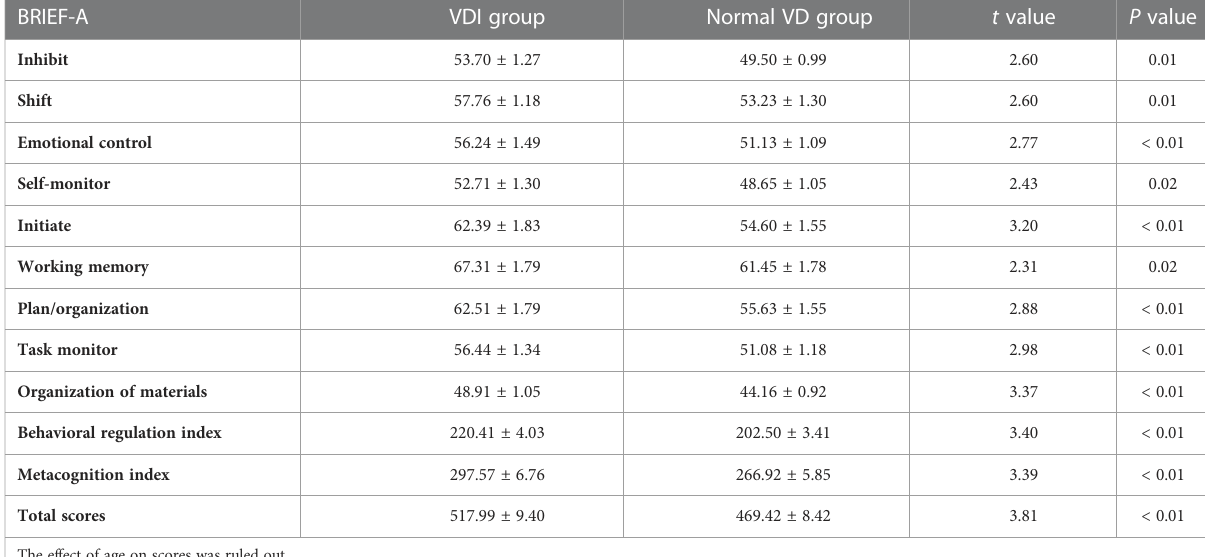
TABLE 3 Differences of BRIEF-A scores in T2DM patients with different 25(OH)D